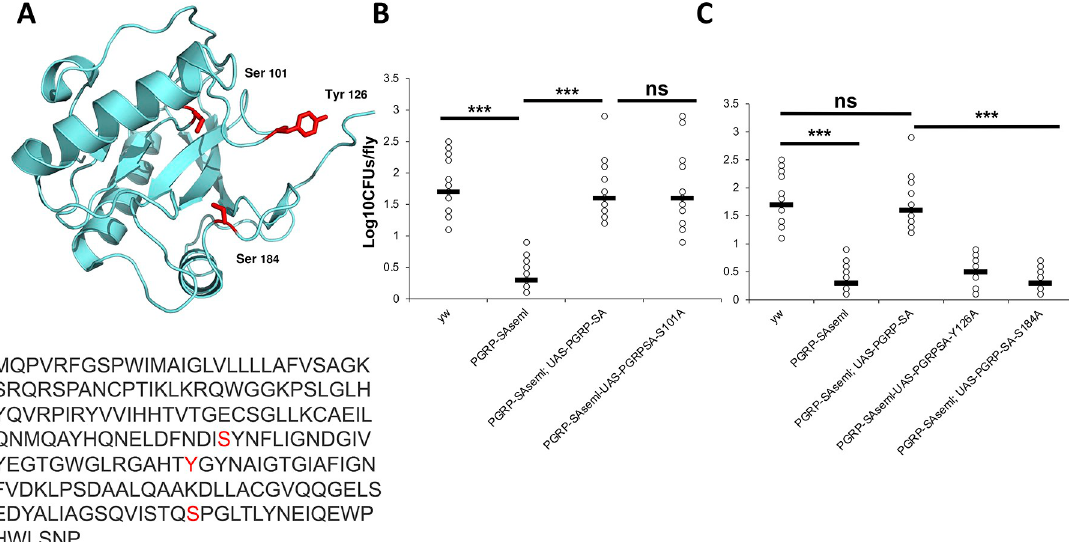
Fig 10. Bacterial sensing by PGRP-SA is important for the maintenance of intestinal bacterial density. (A) Mutations (to Alanine) were introduced in three residues spanning the peptidoglycan binding groove. In vitro studies [48] have indicated that S101A increases peptidoglycan (PG) binding, while Y126A and S184A abolish PG binding. (B) Both a wild-type copy of PGRP-SA and PGRP-SA S101A were able to rescue the significant reduction of CFUs caused by the loss of function PGRP-SA seml . (C) In contrast, PGRP-SA Y126A and PGRP-SA S184A were unable to rescue loss of gut bacterial density. Statistical comparisons were conducted using student’s t-test (ns = not significant, ��� p < 0.001).